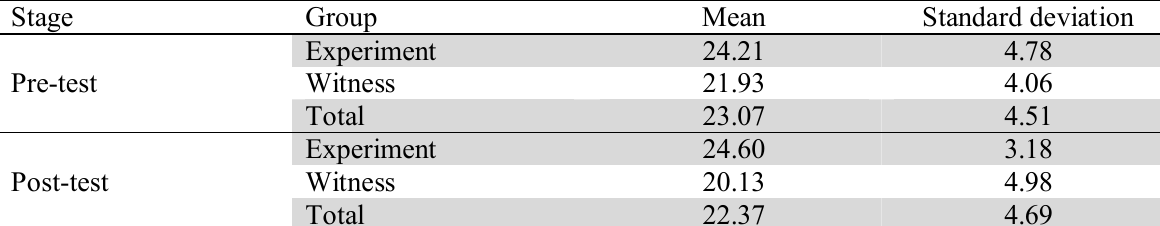
The summary of some basic statistics